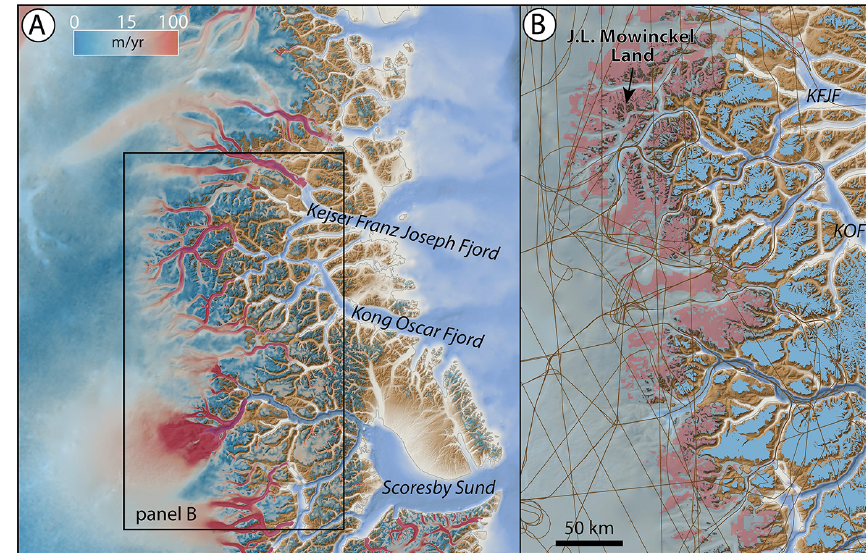
Figure 9. (a) East Greenland showing GrIS flowing through alpine terrain; surface velocity highlights major outlets; velocity from Greenland Ice Sheet velocity map from Sentinel-1, winter campaign 2019/2020 (version 1.3); QGreenland v2.0. (b) Portion of East Greenland that includes the most areas that meet the technical requirements of drilling to the bed. Basemap topography and bathymetry from Morlighem et al.